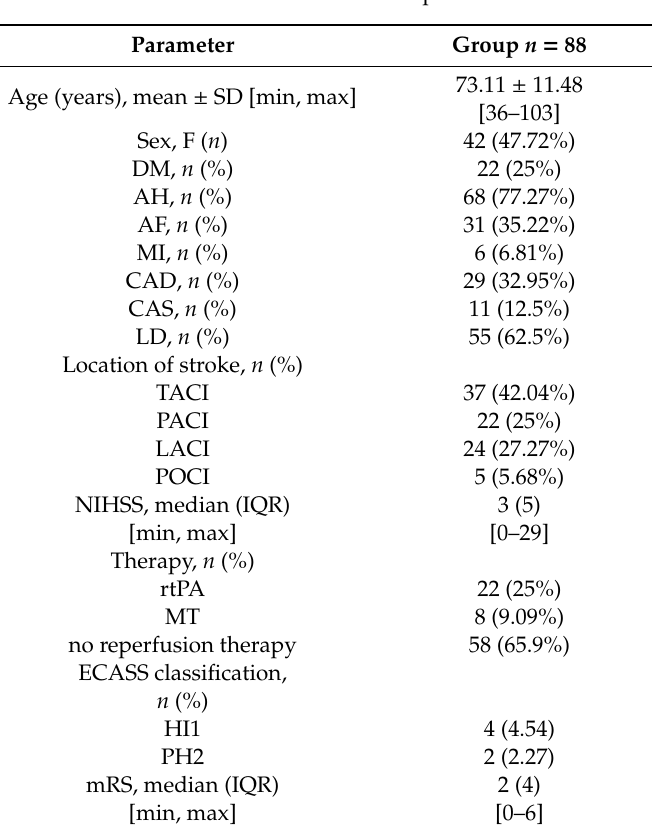
Table 1. Characteristics of the